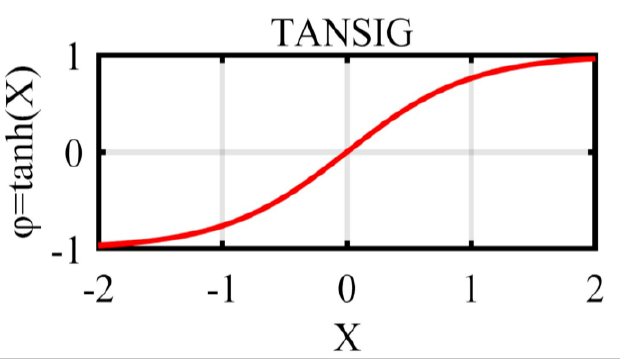
Figure 5. Hyperbolic tangent